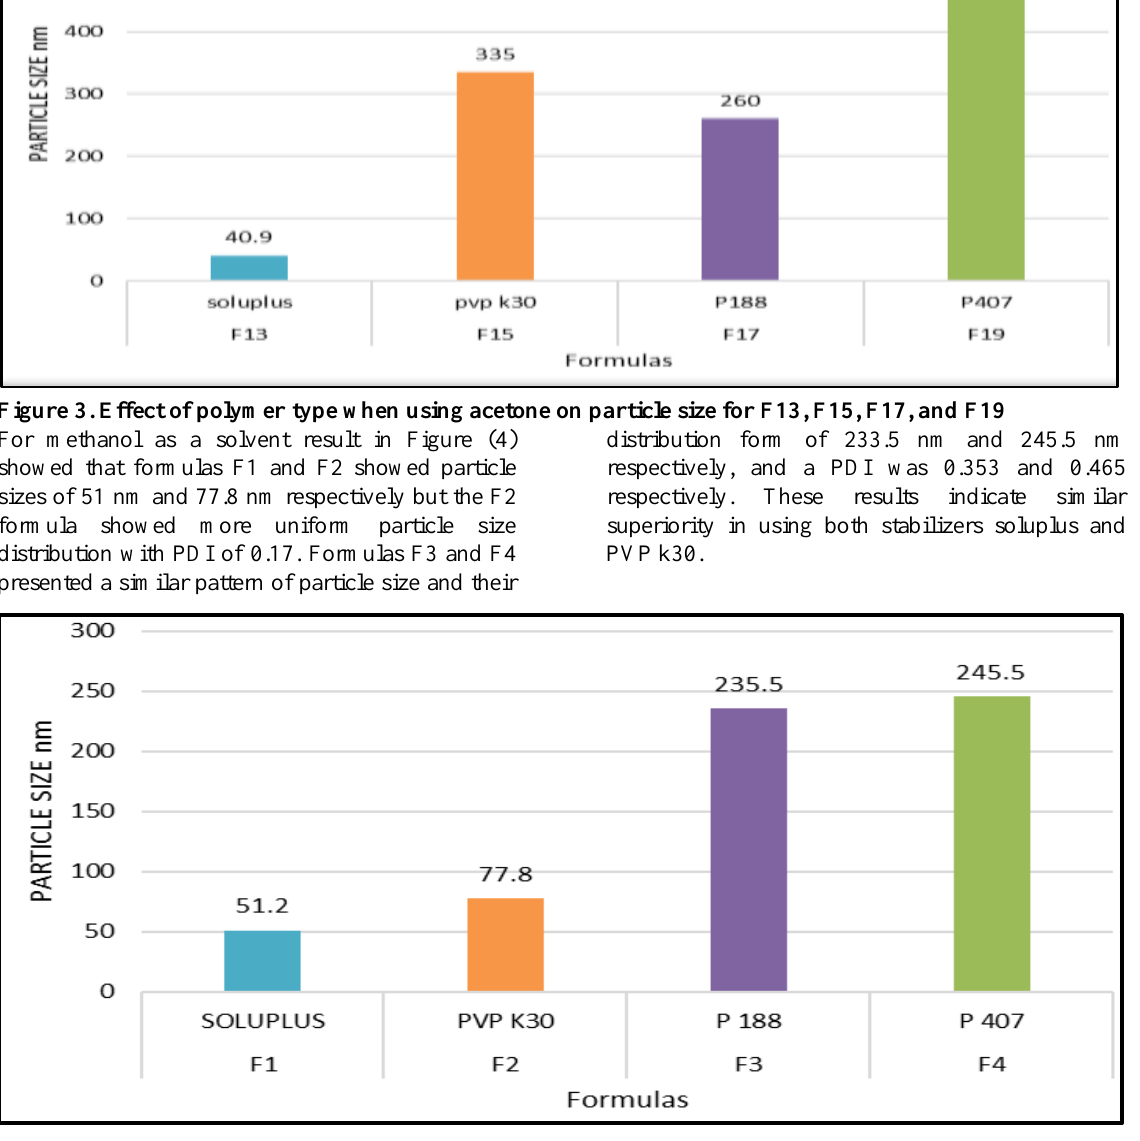
Figure 4. Effect of polymer type when using methanol on the particle size of F1, F2, F3, and